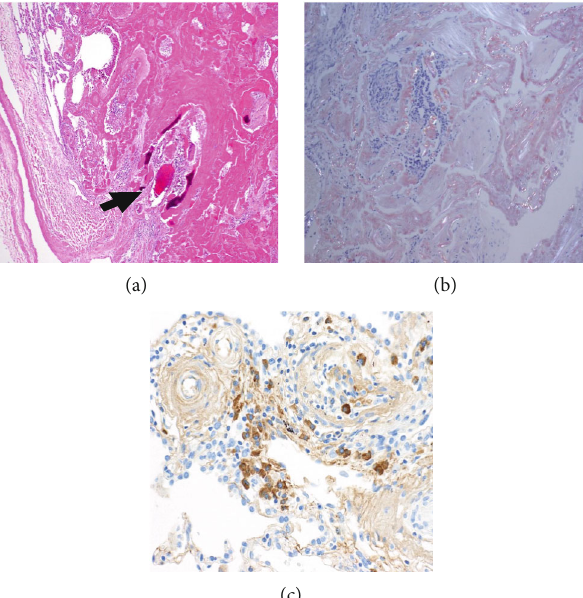
Figure 2: (a) Dense extracellular eosinophilic material, presenting as a mass-like deposit with areas of calci fi cation and ossi fi cation (arrow), perivascular eosinophilic deposits were noted, especially at the periphery of the mass-like deposit, and are seen better in (c). Perivascular eosinophilic material was not seen di ff usely throughout the lung (magni fi cation × 400). (b) Congo red staining when viewed under polarised light (apple-green birefringence under polarised light not visualised) (magni fi cation × 400). (c) Kappa light-chain immunochemistry shows positivity within the amorphous material and plasma cells ( ^ ) (magni fi cation × 400).